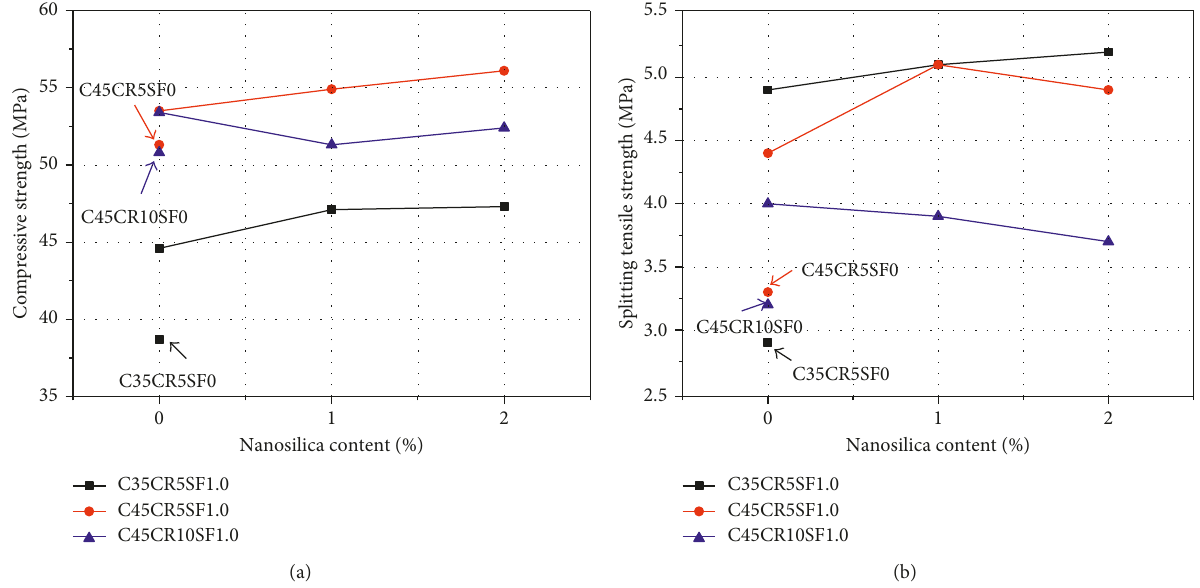
Figure 9: The effect of nanosilica on (a) compressive and (b) splitting tensile